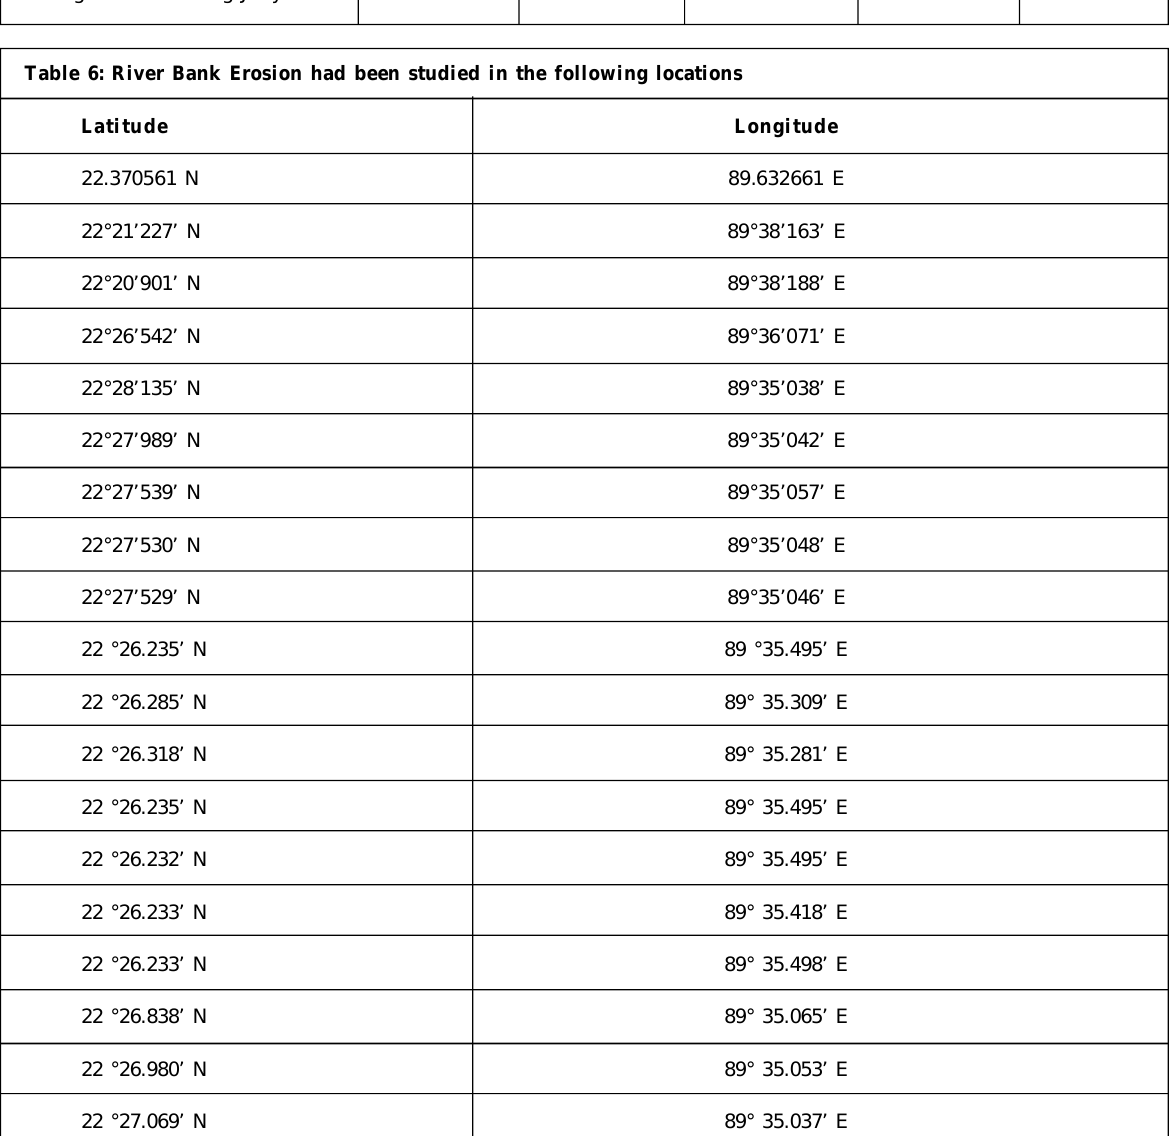
Table 6: River Bank Erosion had been studied in the following locations